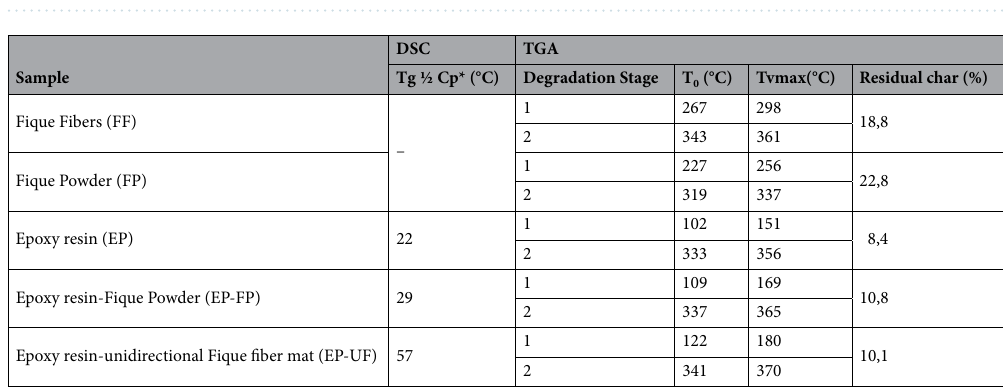
Figure 9. TGA of neat Epoxy resin and EP-fique Biocomposites.